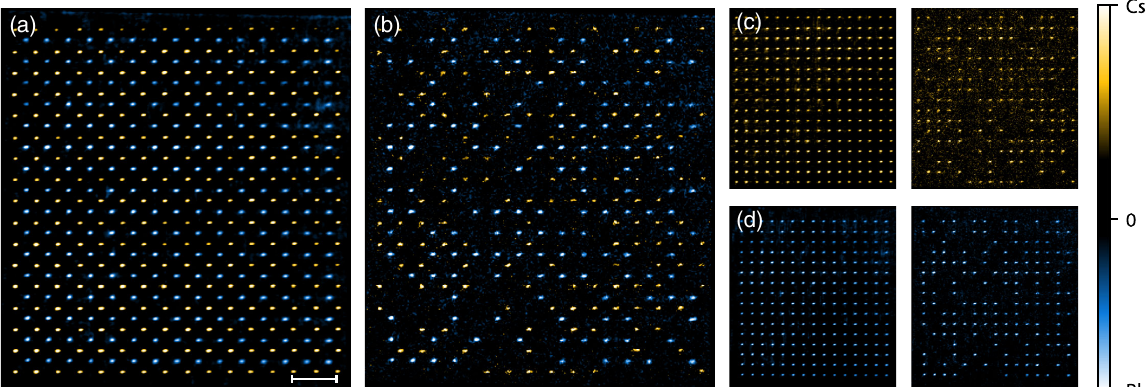
FIG. 2. A dual-element 512-site atom array. Averaged and single-shot single-atom resolved fluorescence images of the dual-element array with Cs counts in yellow and Rb counts in blue. (a) Averaged fluorescence image of the dual-element array. Scale bar indicates a distance of 20 μ m.(b)Single-shotimageofthedual-elementarray.(c)Averagedandsingle-shotimagesofthe 17 × 16 Csarray.(d)Averagedandsingle- shot images of the 16 × 15 Rb array. See Appendixes A and B for detailed imaging sequence, parameters, and fluorescence